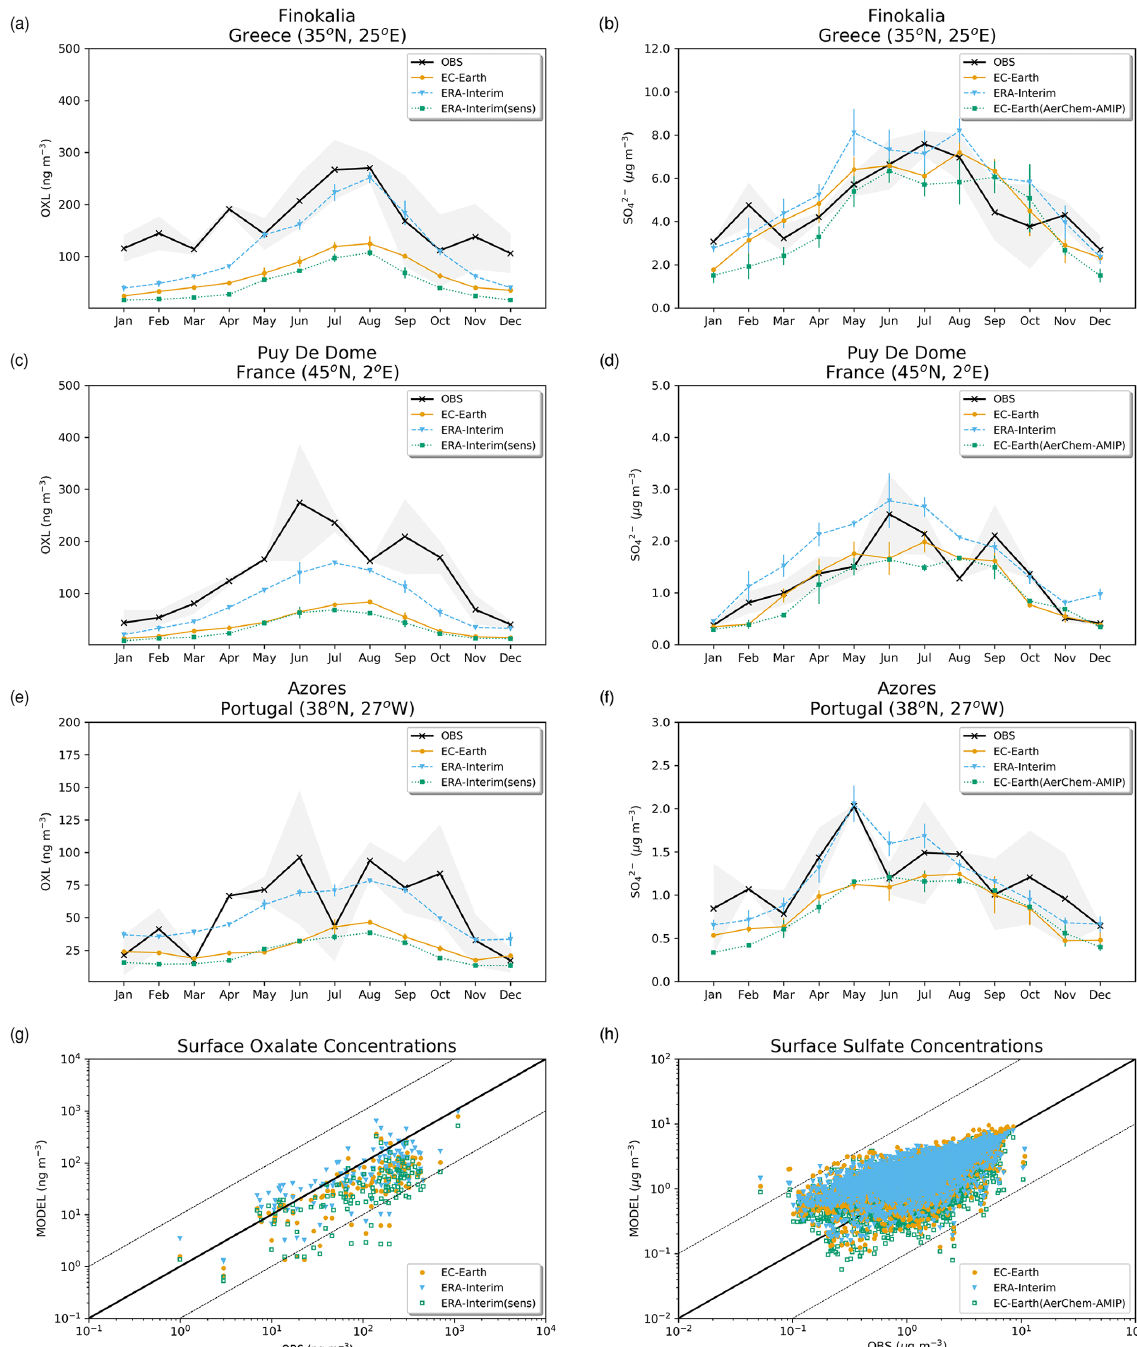
Figure 6. Comparison of daily mean observations (black line) of OXL (ngm − 3 ; a , c , e , g ) and nss-SO 2 − (µgm − 3 ; b , d , f , h ) with the EC- 4 Earth (orange line and circles) and the ERA-Interim (light blue line and triangles) simulations for Finokalia (Greece) (a) , (b) for the period July 2004–July 2006 (Koulouri et al., 2008); for Puy de Dome (France) (c) , (d) and Azores (Portugal) (e) , (f) for the period September 2002– September 2004 (Legrand et al., 2007); and scatterplot comparisons for observations around the globe (d) , (f) ; the solid line represents the 1 : 1 correspondence, and the dashed lines show the 10 : 1 and 1 : 10 relationships, respectively. For completeness, the comparisons for the sensitivity simulation ERA-Interim(sens) for OXL and the EC-Earth(AerChem-AMIP) (green line and squares) for sulfate are also presented. Gray-shaded areas represent the standard deviation of the observations and the color-coded error bars represent the model’s standard error of the multi-annual mean for the individual observational